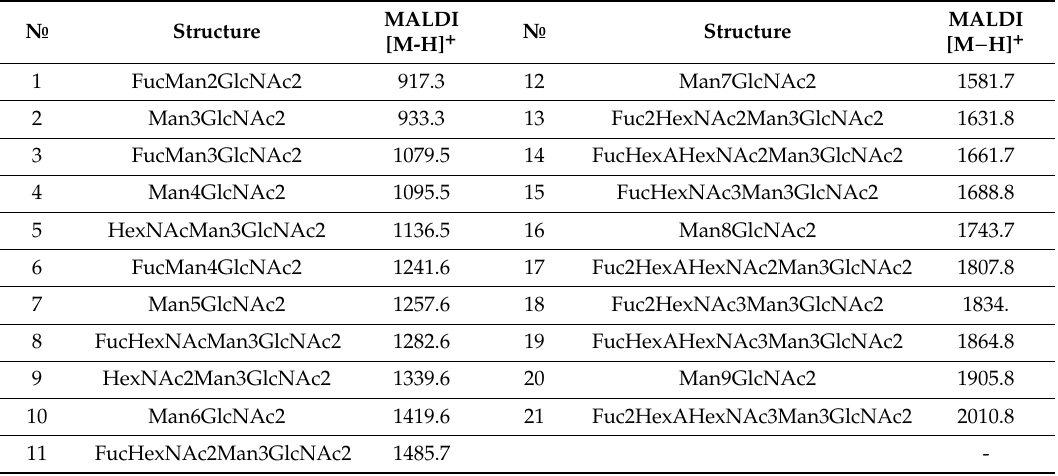
Table 1. Composition of N-glycans in RvH1. ( a ) N-glycans are represented as [M + Na] + ions. Mw